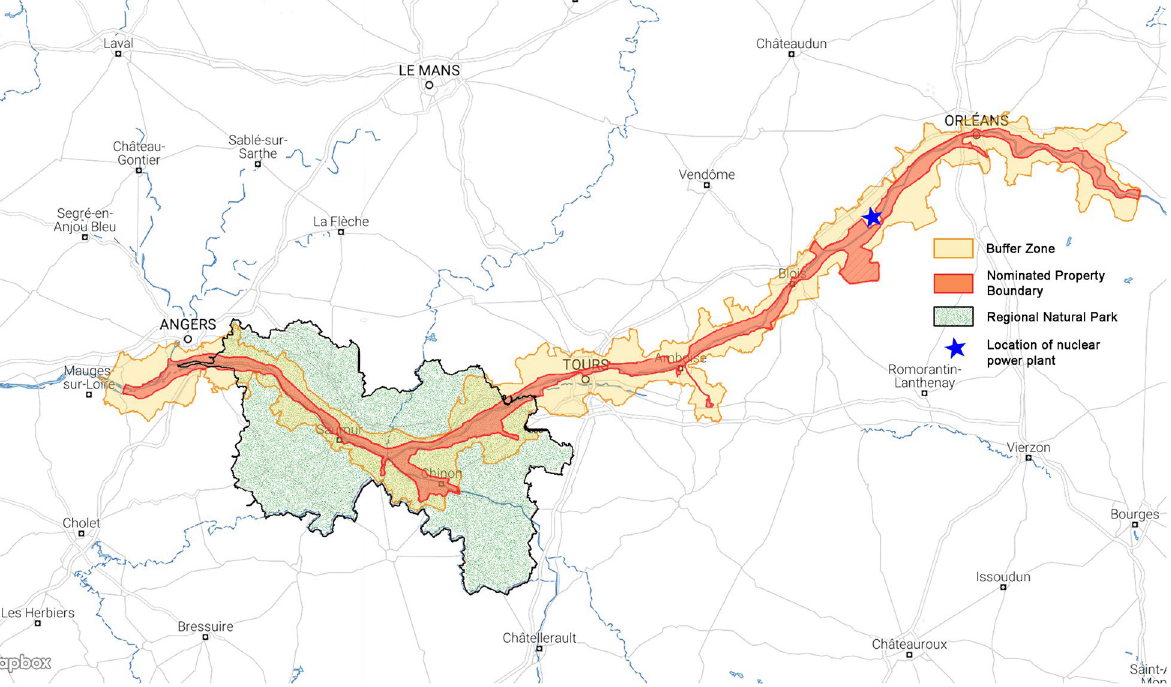
Fig. 3 Location of the nuclear power plant in the buffer zone (Source: Peng